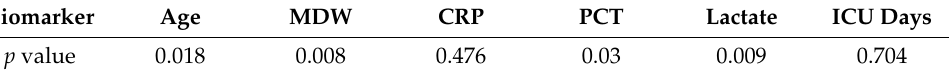
Table 3. Man–Whitney U test.